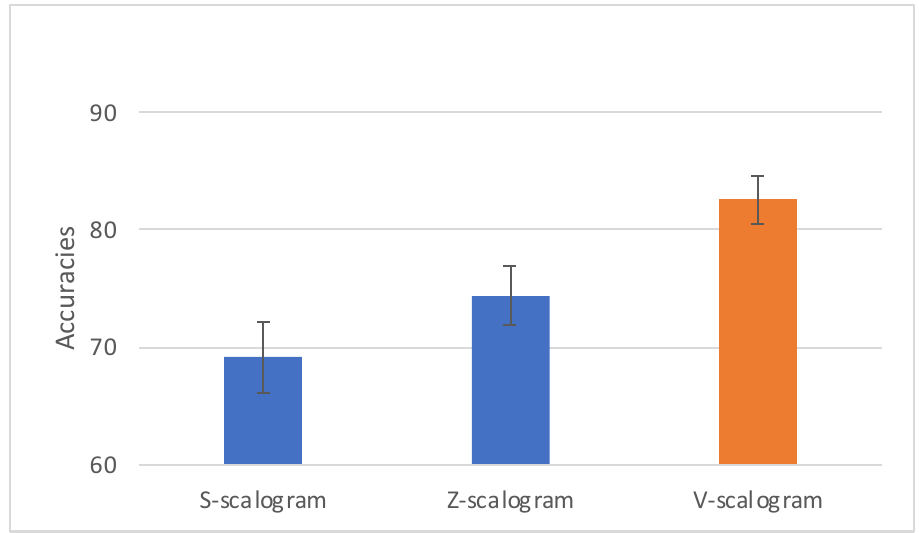
Figure 3. The 95% CIs for the global mean accuracies of the 3 approaches. Table 3. A comparison of the average classification accuracies of the S-scalogram and the V -scalogram